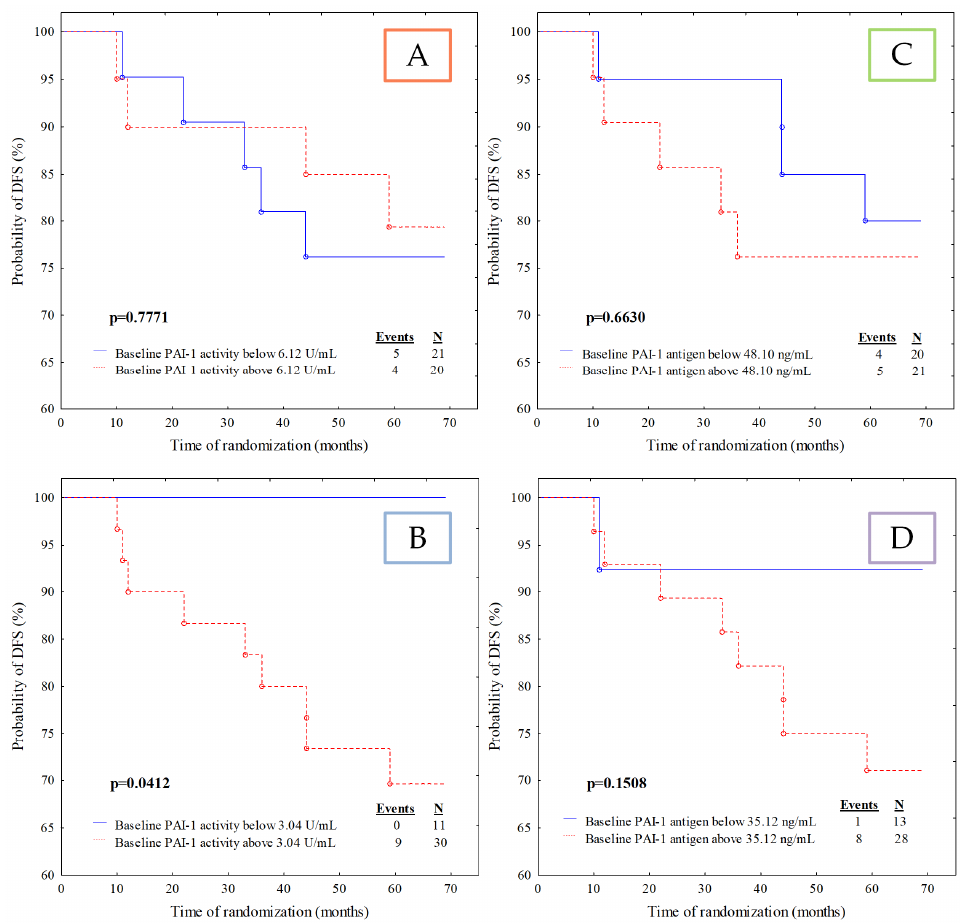
Figure 2. Kaplan–Meier curves for the disease-free survival (DFS) analysis of the studied population regarding ( A ) PAI-1 activity divided according to median value cut-off; ( B ) PAI-1 activity divided according to ROC cut-off; ( C ) PAI-1 antigen divided according to median value cut-off; ( D ) PAI-1 antigen divided according to ROC cut-off. According to Kaplan–Meier analysis for t-PA antigen with a cut-off point based on the median value, we observed that the survival rate was worse in patients with t-PA